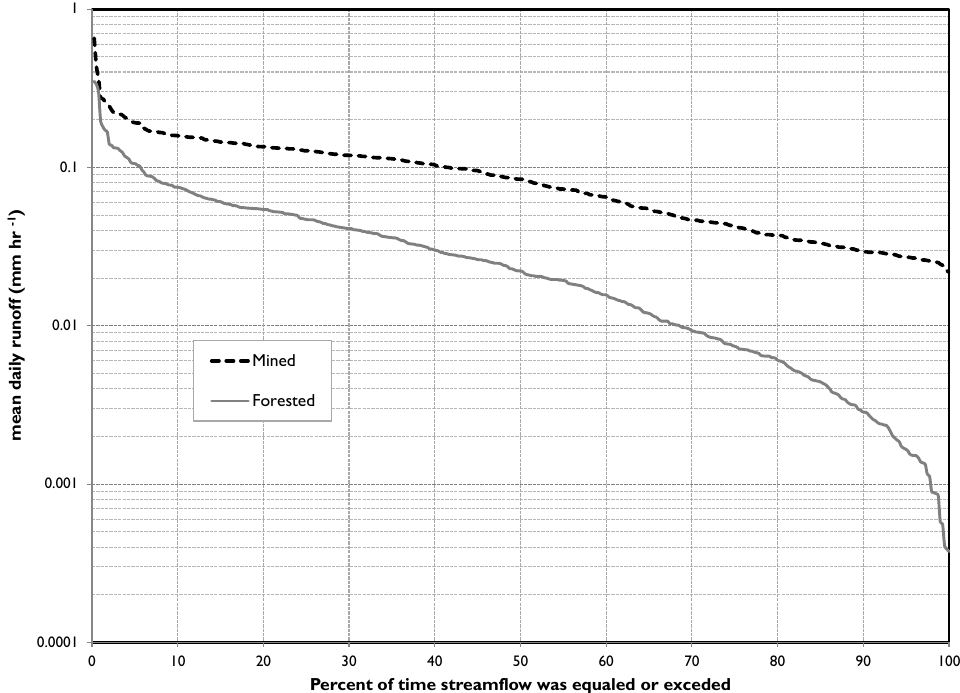
Figure 4. Flow duration curves for the mined and forested catchments from 1 September 2011–30 September 2012 showing the different flow regimes; runoff in the mined catchment is consistently greater than the forested catchment during all times of the study period, particularly during base flow conditions when flow is sustained by valley